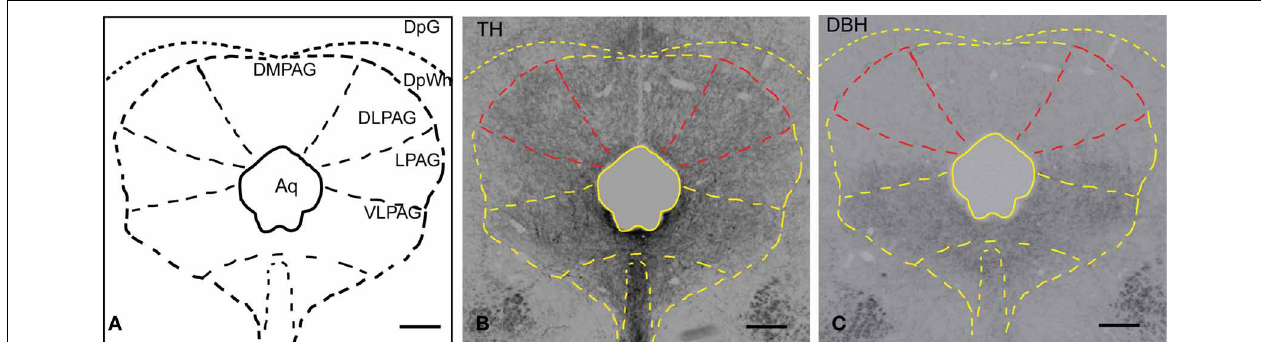
FIGURE 1 | Distribution of TH and DBH immunoreactivity in the PAG. (A) Schematic representation of the PAG and adjacent nuclei. (B) Micrograph of a coronal section showing TH-labeled fibers and terminals in the PAG and deep layers of the SC. The dlPAG is outlined in red; the subdivisions of the PAG are depicted in yellow. (C)